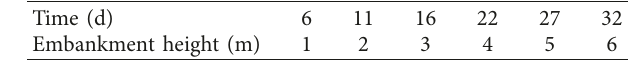
Figure 20: Numerical reproduction of the settlement process. Table 3: Construction